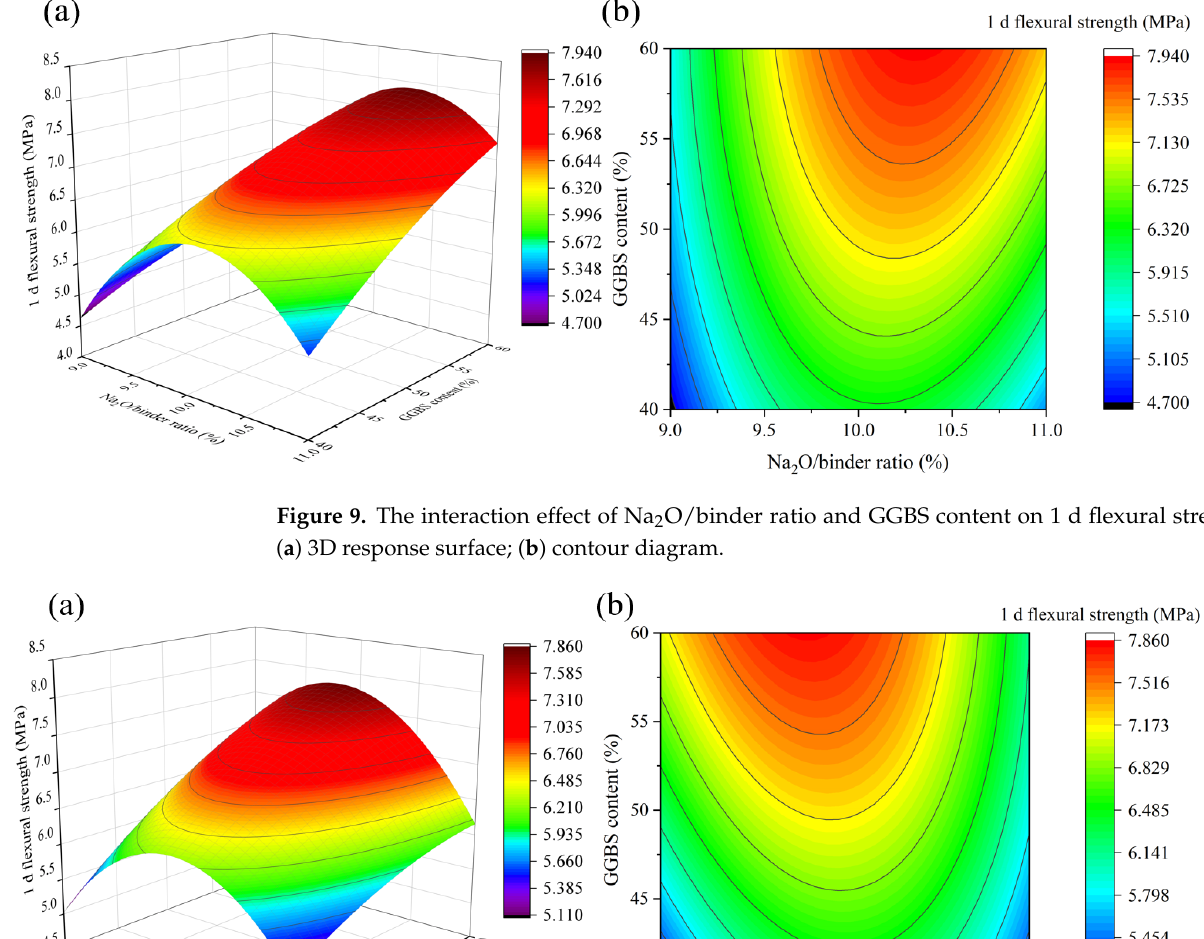
Figure 11 . The interaction effect of water/binder ratio and GGBS content on 1 d flexural strength: ( a ) 3D response surface; ( b ) contour diagram.